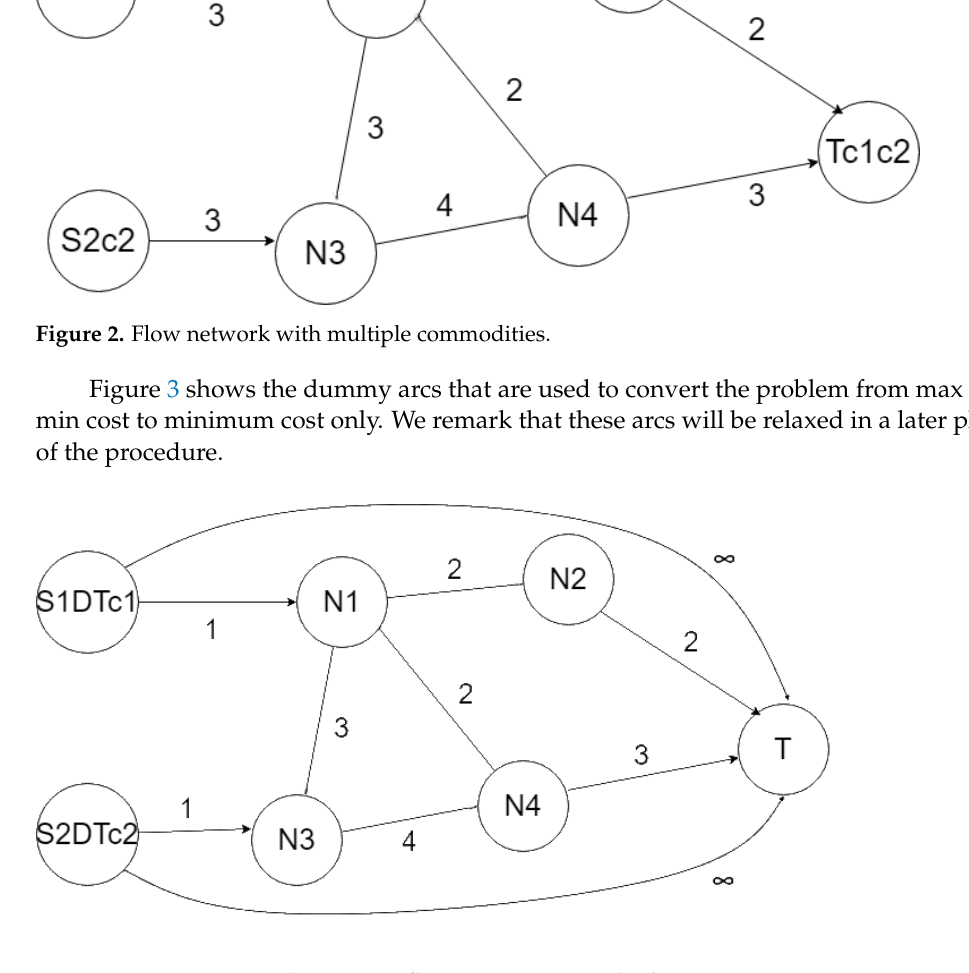
Figure 3. Min cost equivalent to max flow min cost network of Figure